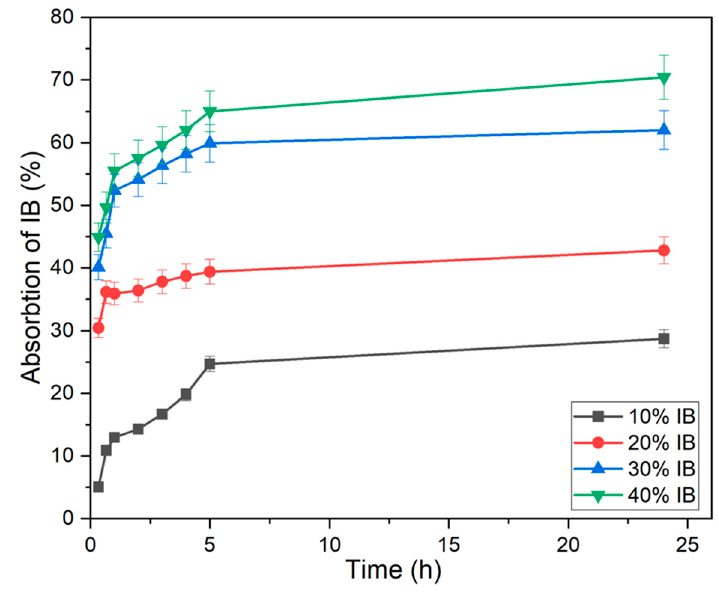
Figure 9. Optimization of the amount of IB for the absorption of IB.